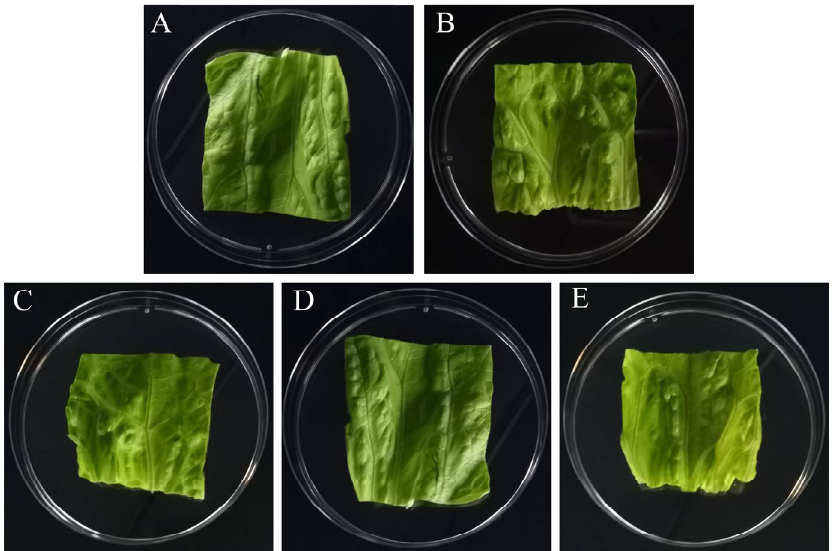
Figure 9. Lettuce leaves treated with different concentrations of linalool. ( A ) Untreated group. ( B ) Lettuce treated with linalool at 1/2× MIC. ( C ) Lettuce treated with linalool at 1× MIC. ( D ) Lettuce treated with linalool at 3/2× MIC. ( E ) Lettuce treated with linalool at 2× MIC.